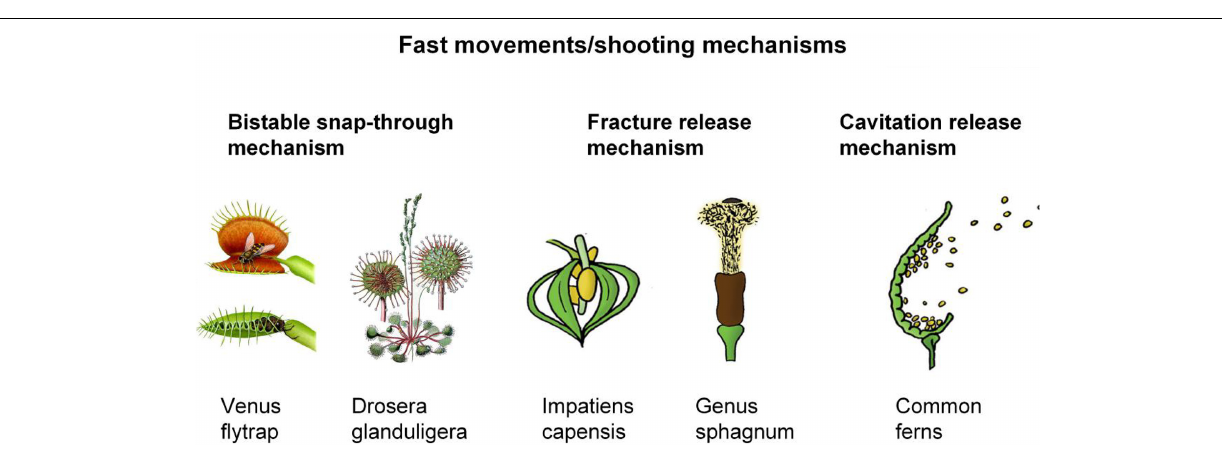
FIGURE 3 | Further classification of mechanic instabilities into bistable snap-through mechanism, fracture release mechanism, and cavitation release